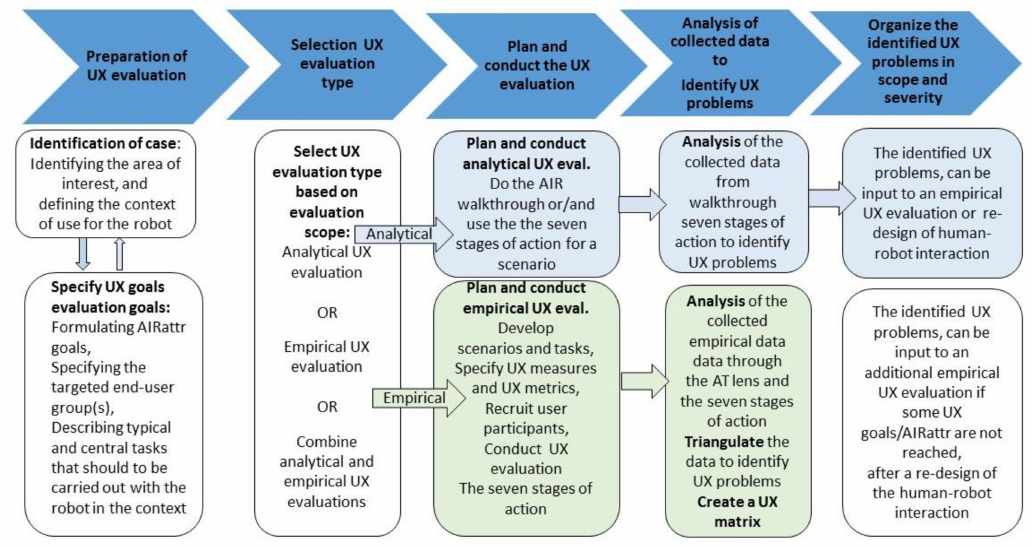
Figure 4. The overall description of the phases in the ANEMONE